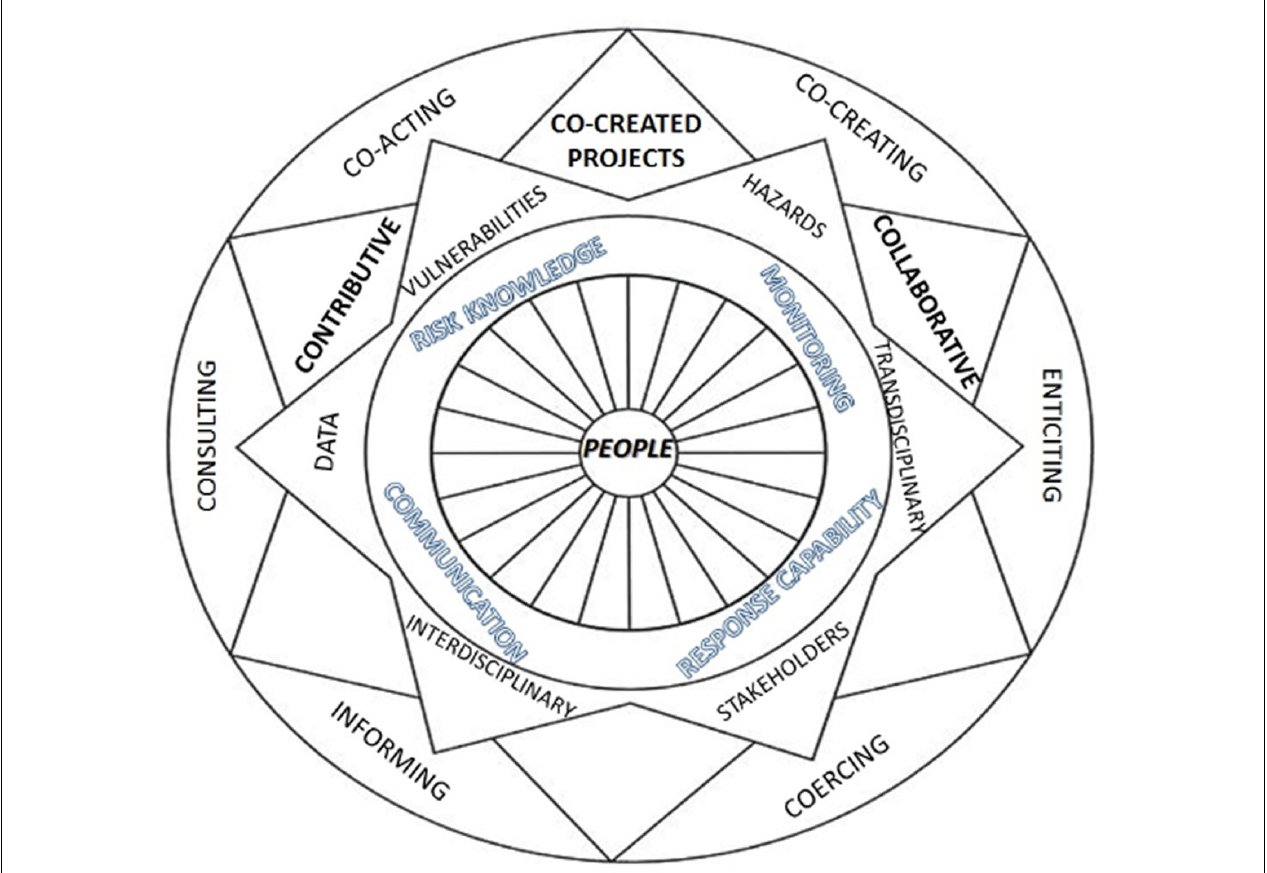
FIGURE 10 | Framework for enhancing reflexivity about PEWS and citizen science. Source: the